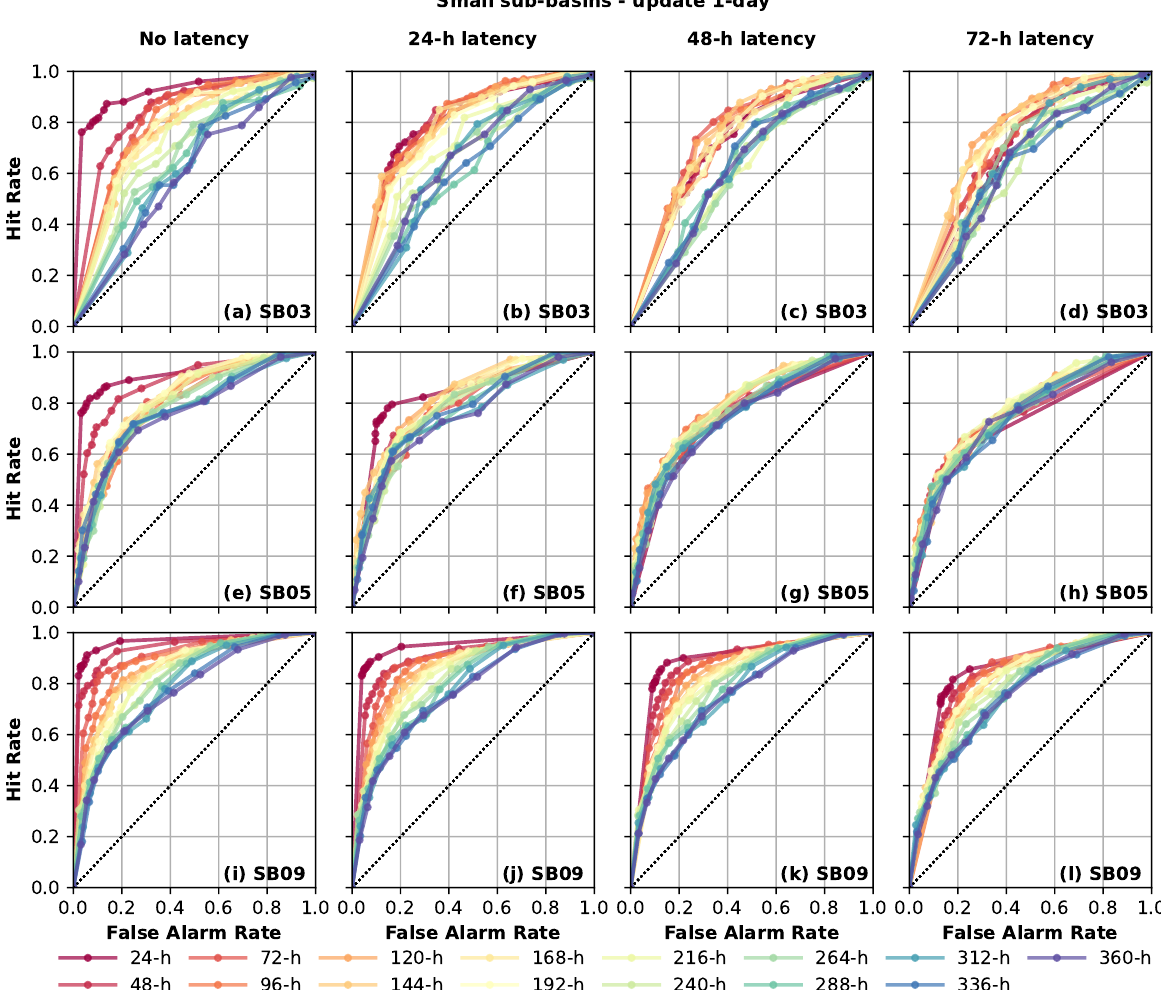
Figure 8. ROC diagrams of the probabilistic streamflow forecast for small sub-basins. MHD-INPE 1 d update for: no latency (left column), 24 h latency (center-left column), 48 h latency (center-right column), and 72 h latency (right column), for streamflow with a probability level of